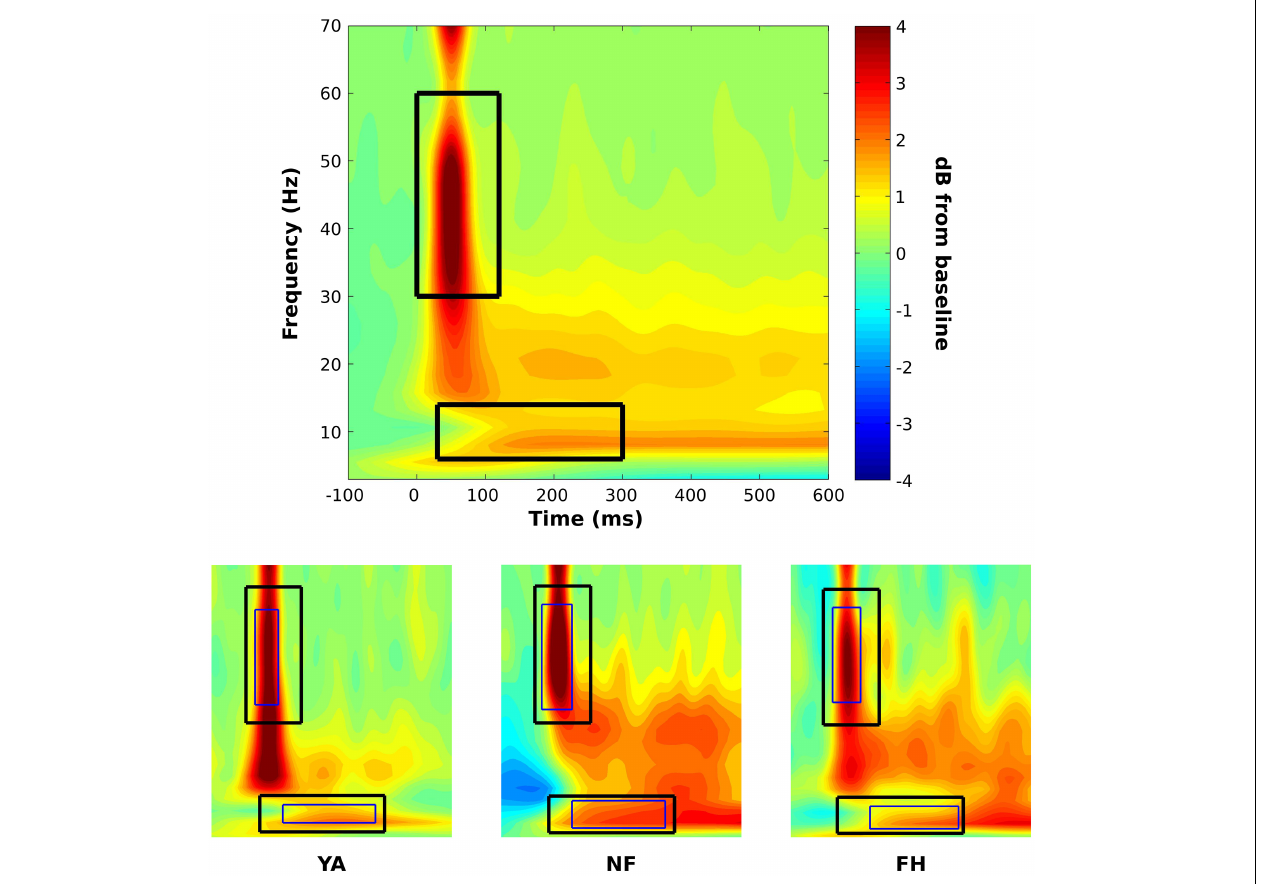
FIGURE 2 | Time-frequency windows for statistical analysis on power spectra. A time-frequency plot that was constructed across groups and conditions (top panel) was visually inspected to identify initial time-frequency windows to extract average alpha (lower box) and gamma power (higher box). Using these pre-defined constraints, subject specific time-frequency windows (bottom panel; thin box within group-defined box) were identified for alpha and gamma using time-frequency plots that were averaged across conditions within each subject. Representative subject-specific time-frequency windows are displayed on time-frequency plots of the respective YA (bottom panel, left plot), NF (bottom panel, middle plot), and FH (bottom panel, right plot) participants. Power values are displayed in